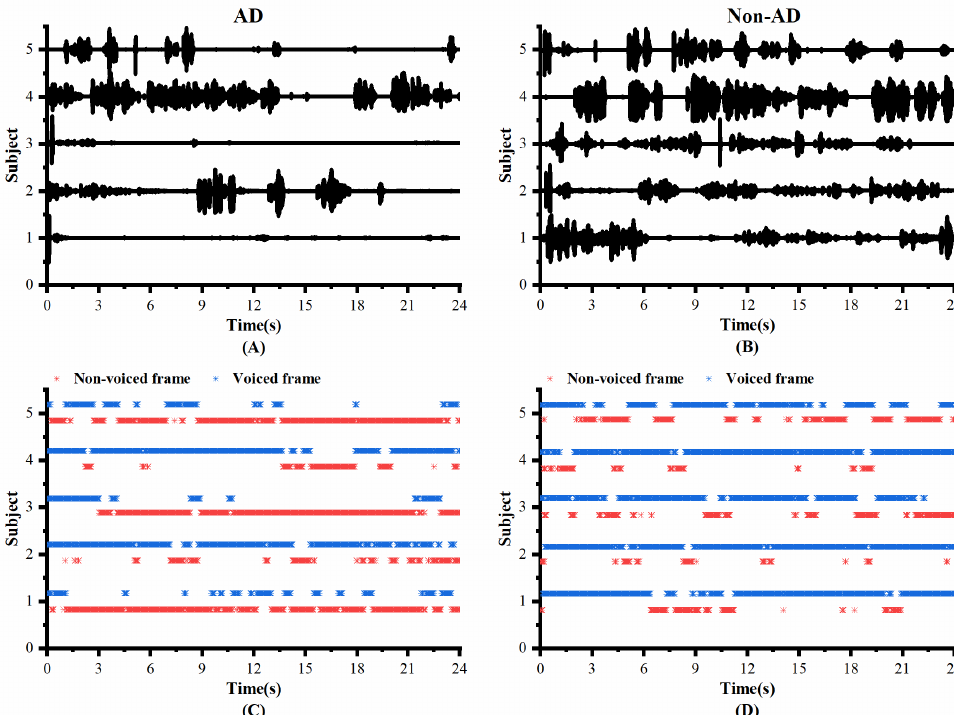
Figure 4. Contrast display of representative signals from AD and non-AD subjects: ( A ) raw audio recordings of AD; ( B ) raw audio recordings of non-AD; ( C ) VAD Pause features of AD; ( D ) VAD Pause features of non-AD. The blue asterisks represent voiced frames, whereas red represent non-voiced frames in the figure of pause features.